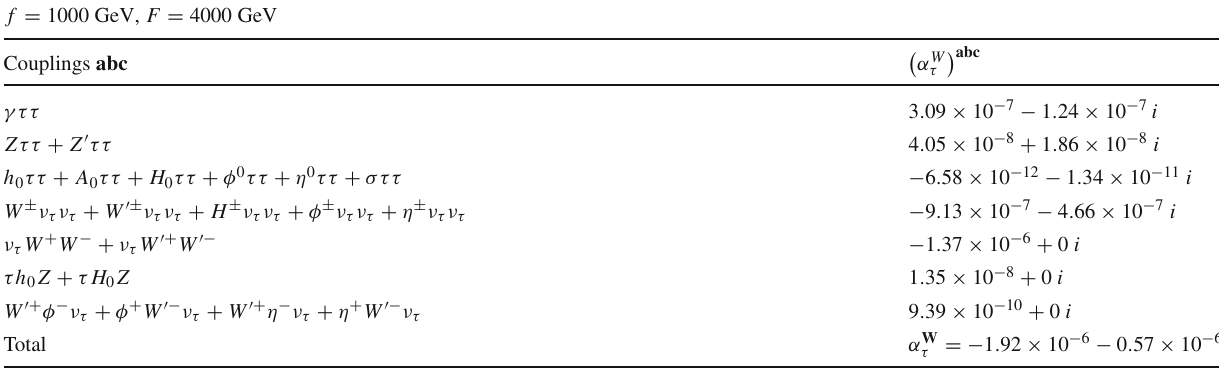
Table 7 Partial contributions to α W τ . abc denotes the different particles running in the loop of the vertex Z τ + τ − f = 1000 GeV, F = 4000